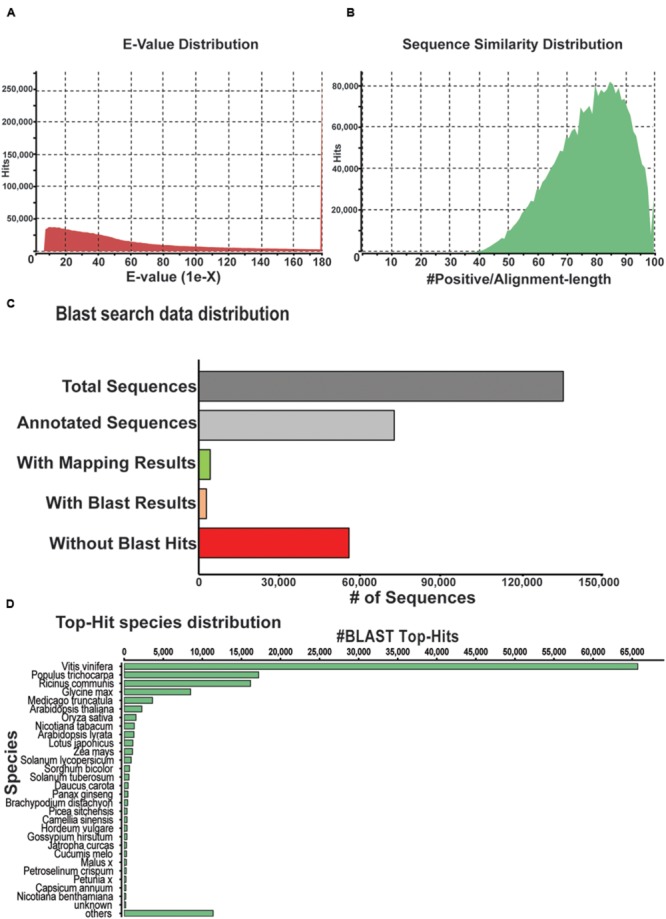
Characterization of P. japonicus unigenes based on NCBI non-redundant (nr) protein database search. (A) E-value distribution of Blast hits for the P. japonicus assembled transcriptome with a cutoff of E-value < 10-5. (B) Similarity score distribution plot of top Blast hits for the assembled unigenes. (C) Bar chart of the data distribution based on blast search and annotation using Blast2GO. (D) Species distribution of the top Blast hits for the assembled unigenes.